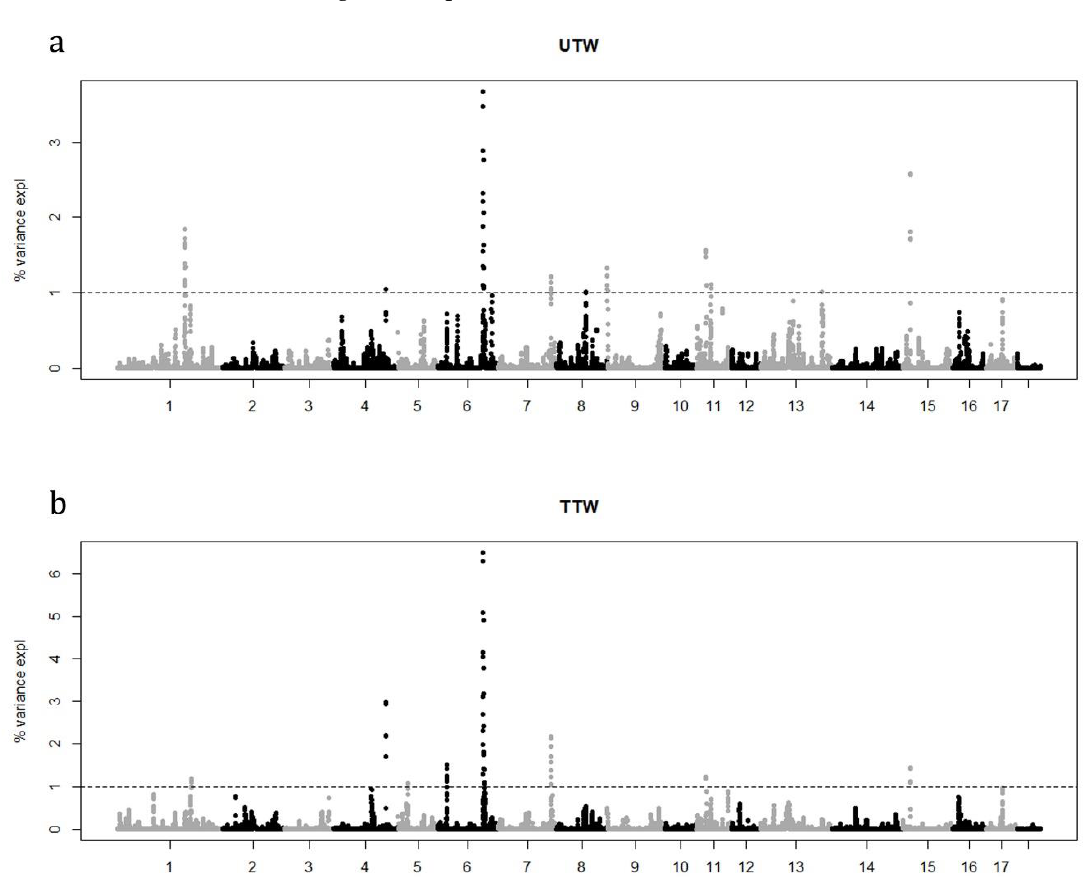
Figure 1. Manhattan plots of the percentage of additive genetic variance explained by windows of 10 adjacent SNPs for UTW, untrimmed thigh weight ( a ) and TTW, trimmed thigh weight ( b ).